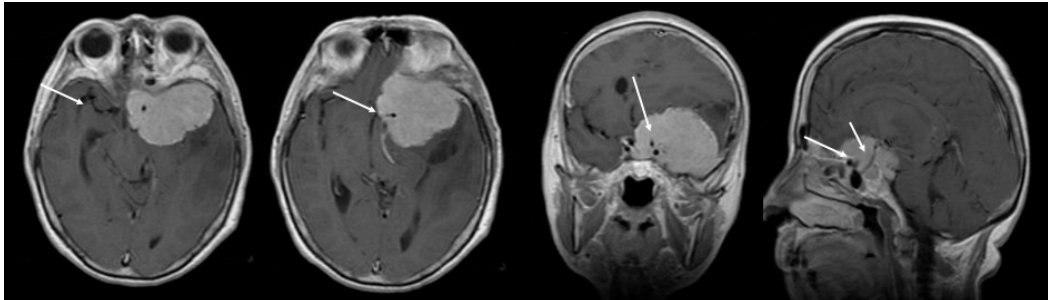
Figure 2. Total arterial encasement—internal carotid artery (ICA) -white arrow.